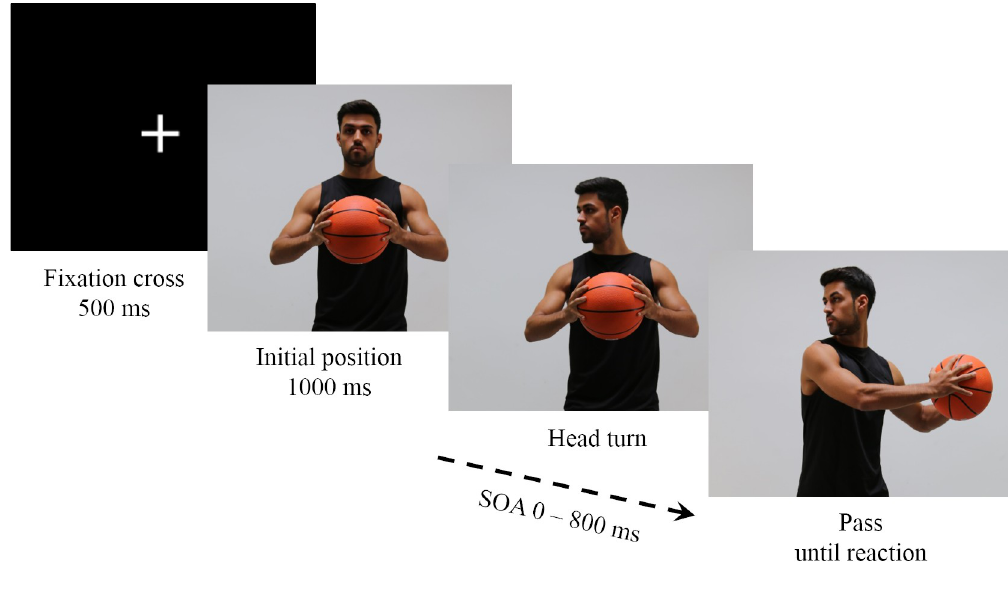
Fig 2. Sequence of a